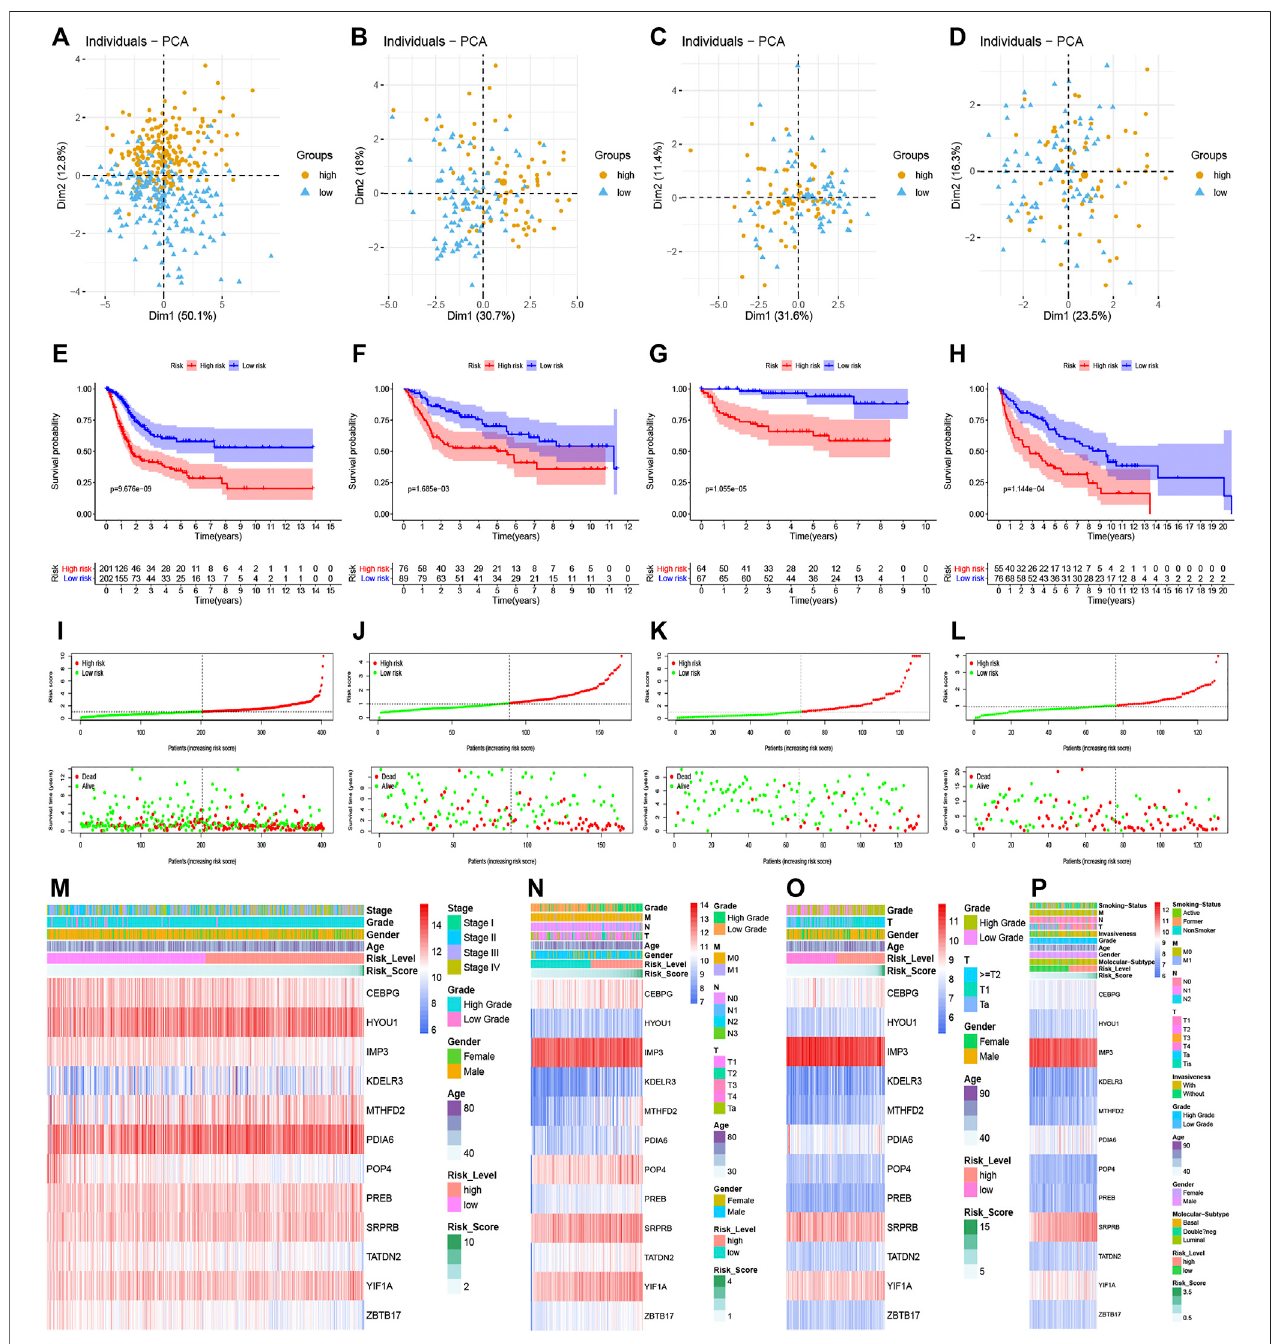
FIGURE 3 | Prognostic performance of the UPR-related signature in the training set and validation sets. (A – D) The UPR-related signature could signi fi cantly distinguish patients with different risk scores, and patients with higher risk scores had a worse survival time than ones with lower risk scores (E – H). (I – L) Along with the increment ofriskscores,the mortality ratesofpatientsincreased, while overall survivalofpatientswasshortened. (M – P) Multi-groupheatmaps showed the tendency of signature gene expression and clinicopathological parameters in the training and validation sets.